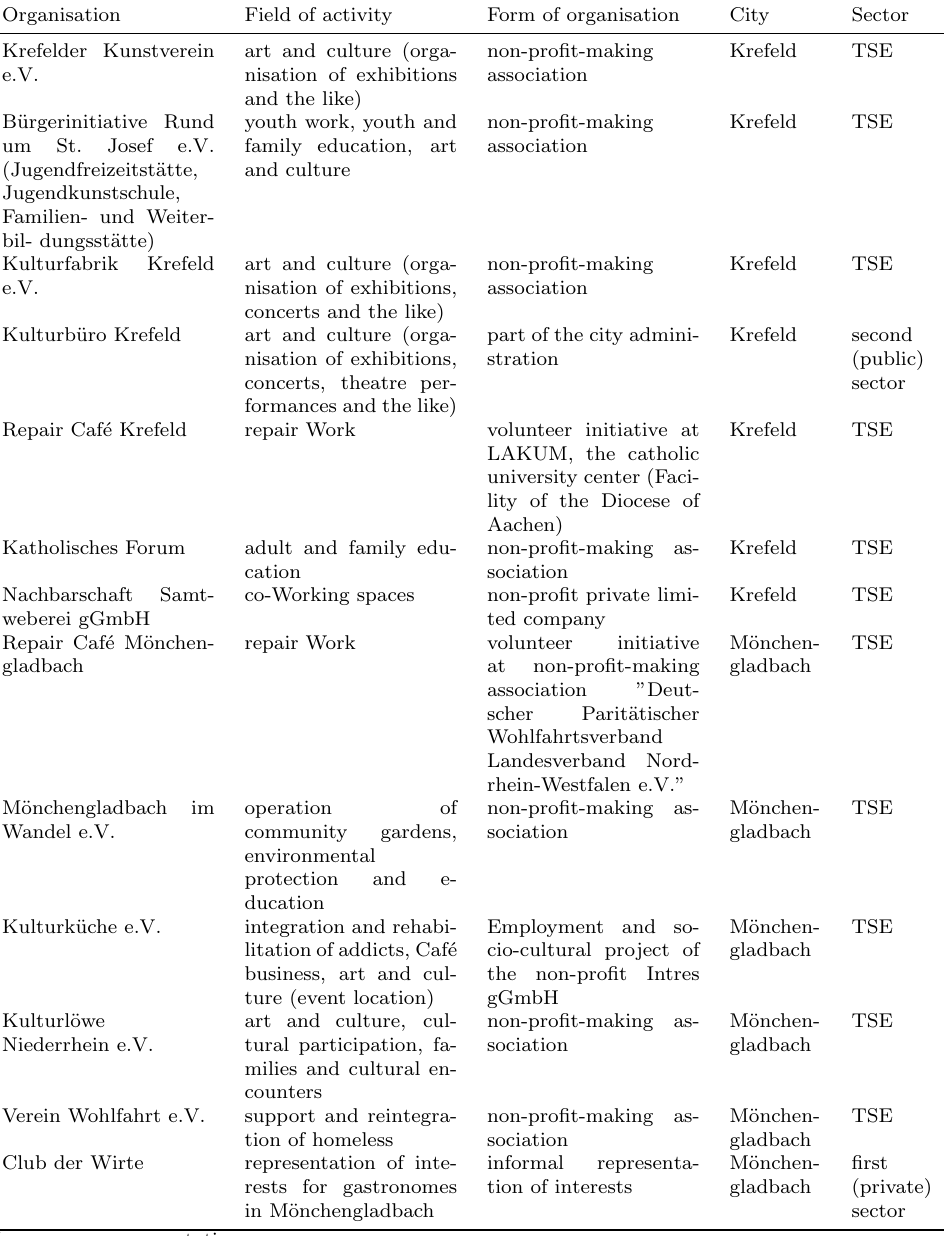
Table 3: Overview of organisations included in the case study